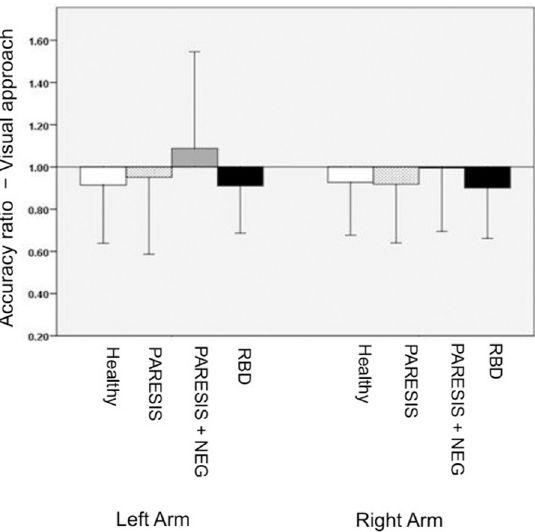
Fig 3. Experiment 1 (arm length estimate − visual approach): Mean accuracy ratios of the four subject groups measured in the acute phase of the stroke. Bars represent standard deviations. Healthy, non-brain damaged controls without neurological or psychiatric disorders; PARESIS, arm paresis without additional spatial neglect or anosognosia; PARESIS+NEG, arm paresis and additional spatial neglect but no anosognosia; RBD, right brain damaged control patients without arm paresis, neglect or anosognosia.